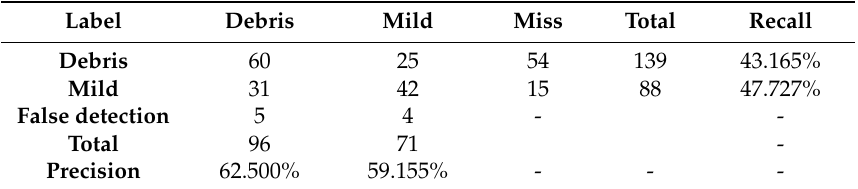
Table 2. The results of the single-shot multibox detector (SSD) method in the test dataset.